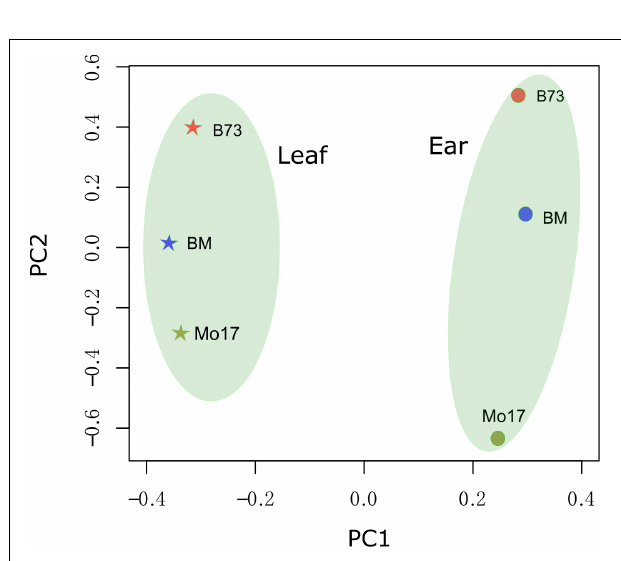
FIGURE 2 | Principal component analysis (PCA) performance for strand-specifically sequencing samples. The symbol “BM” represents the hybrid between B73 and Mo17 (B73 × Mo17). The lines B73, Mo17, and BM are represented by orange, blue, and yellow, respectively. The immature ear and leaf tissues are represented by a circle and a pentagram,